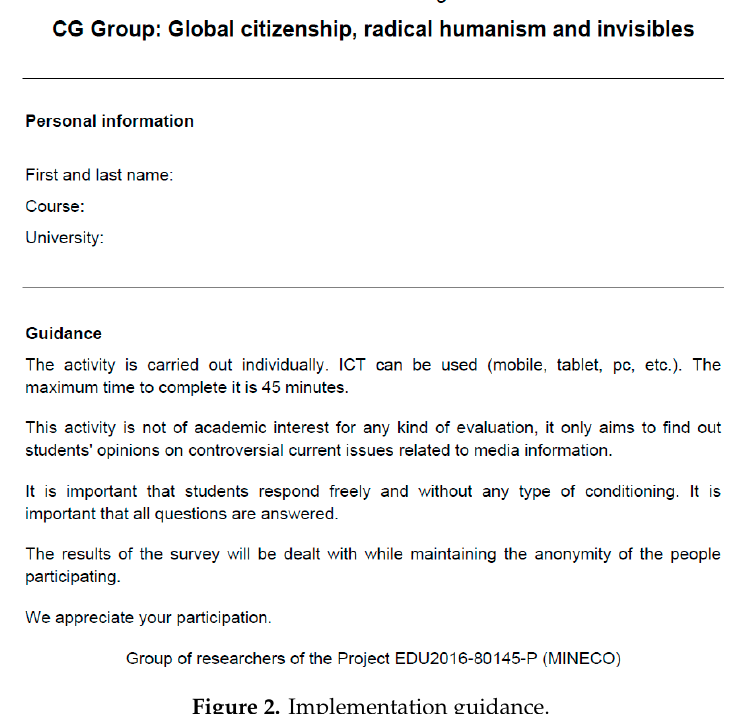
Figure 2. Implementation guidance.